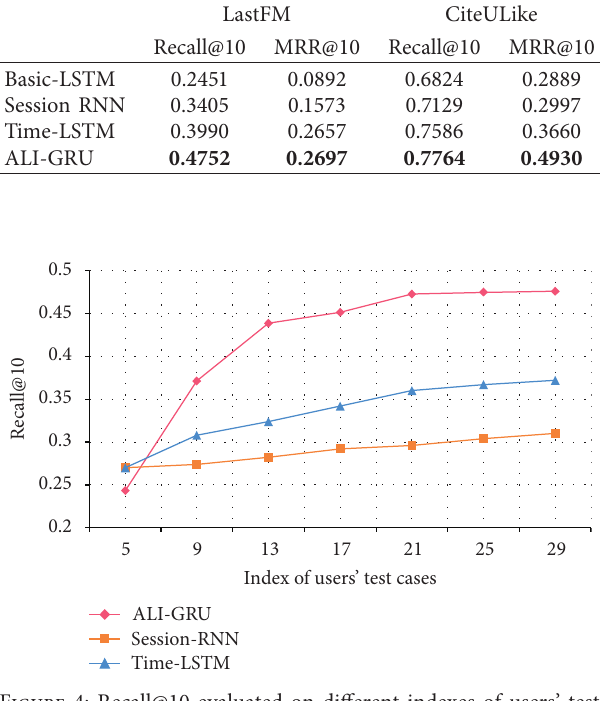
Figure 4: Recall@10 evaluated on different indexes of users’ test cases in